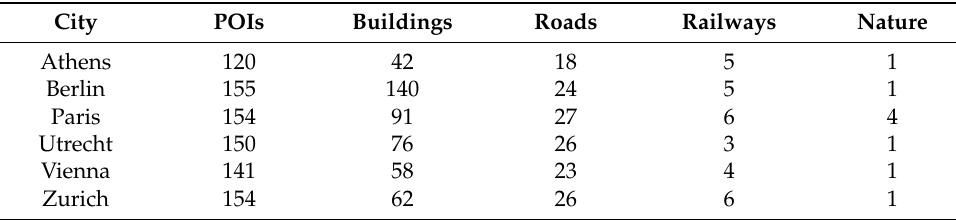
Table 3. Number of unique values in the “Type” tag for each thematic layer and city.